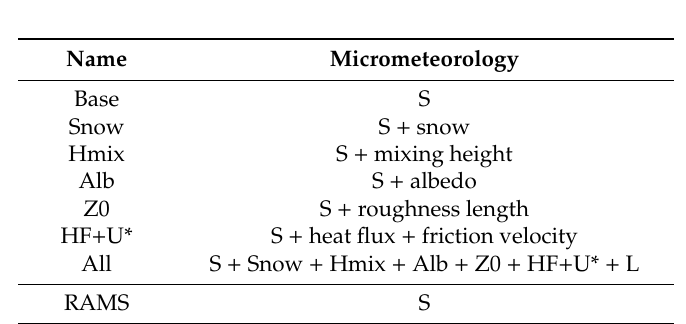
Table 2. Micrometeorological configurations for the sensitivity analysis. S is the baseline configuration with all micrometeorological variables produced by SURFace–atmosphere interface PROcessor (SURFPRO). S + variable is the configuration, where the variable is produced by the Weather Research and Forecasting Model (WRF), while the remaining micrometeorological variables are produced by